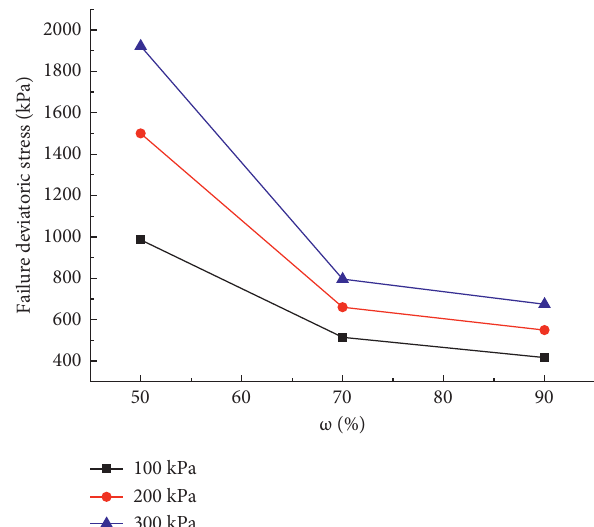
Figure 13: Relationship between failure deviatoric stress and water